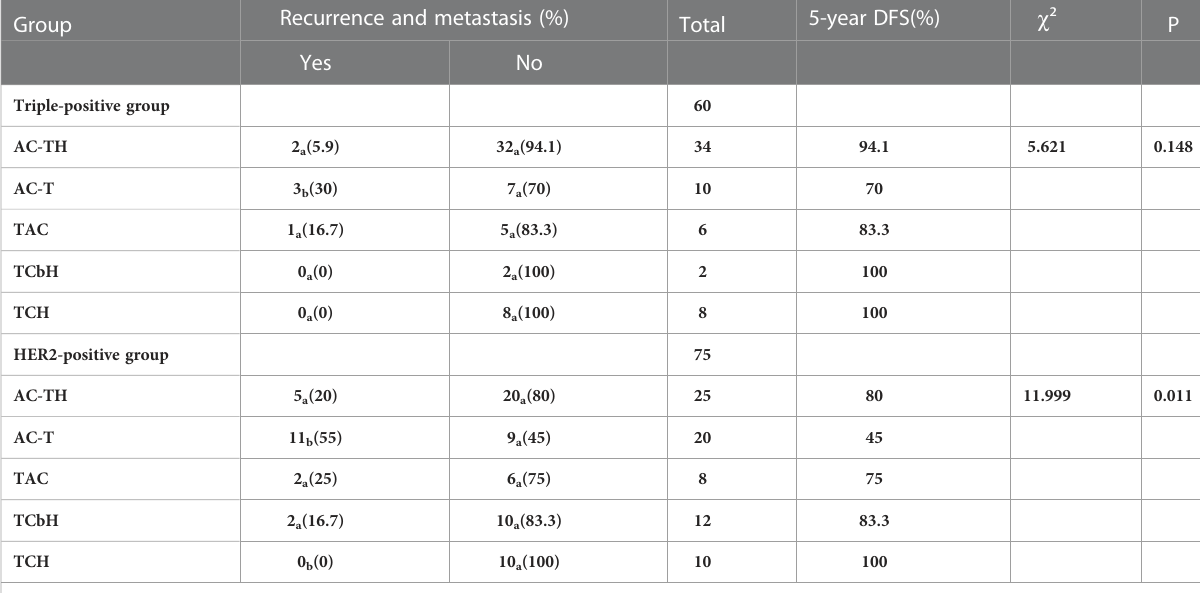
TABLE 4 Recurrence and metastasis in the triple-positive and HER2-positive groups using different chemotherapy regimens. Group